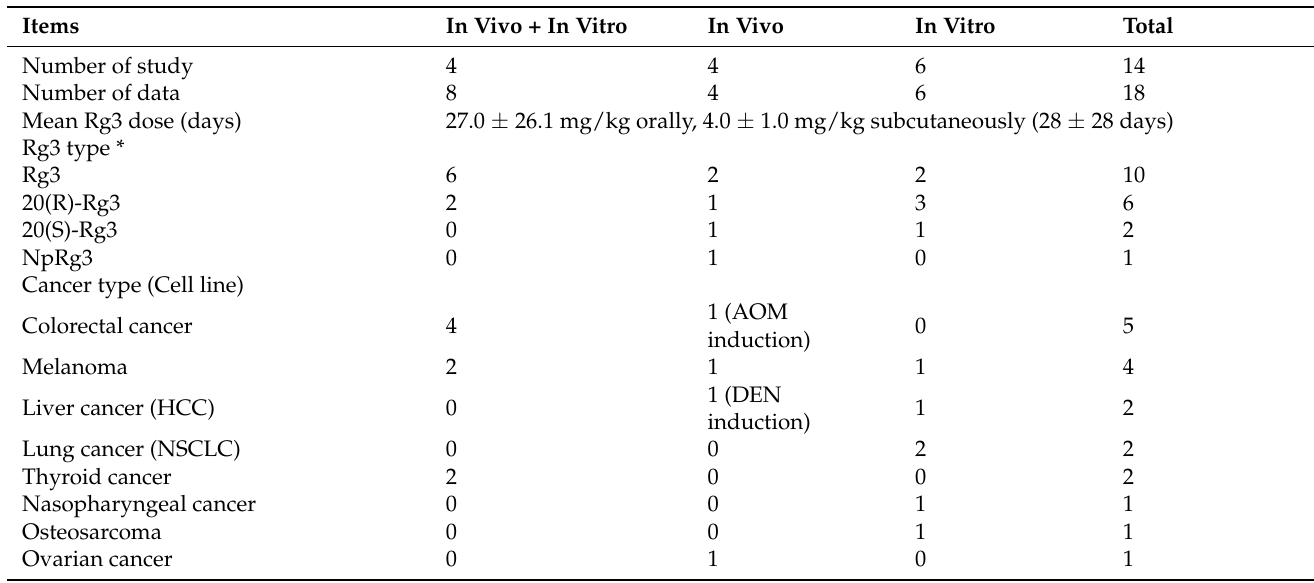
Figure 1. Flow diagram of literature search process. Table 1. Characteristics of 14 included studies.